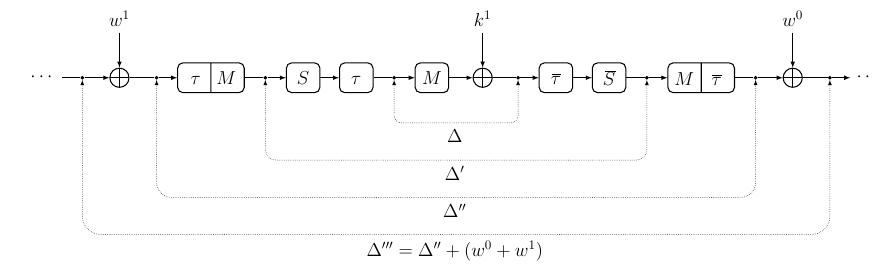
Figure 11: Reflection